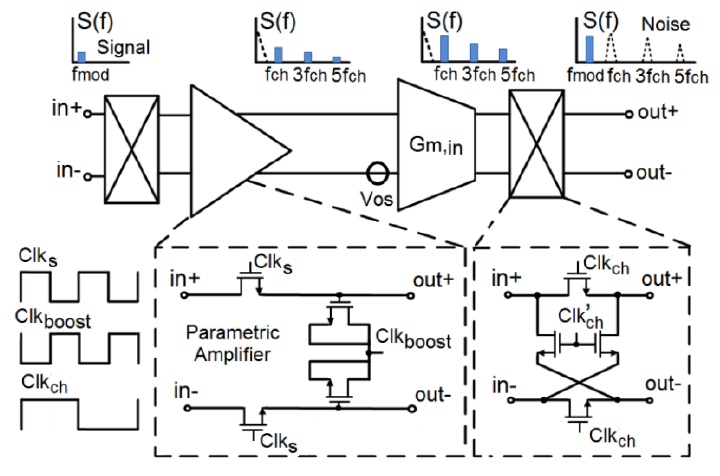
Figure 6. 1/ f noise and offset cancellation by using the parametric chopper amplifier.